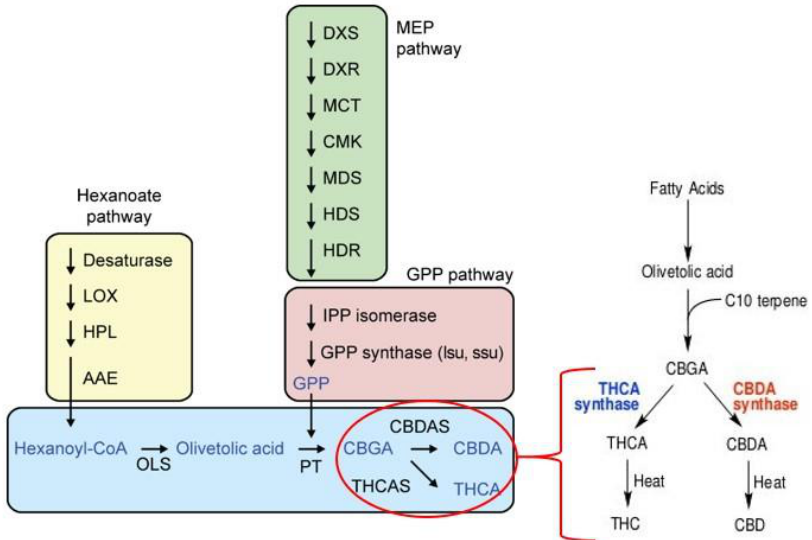
Figure 3. The phytocannabinoids biosynthesis pathway in cannabis and its related gene